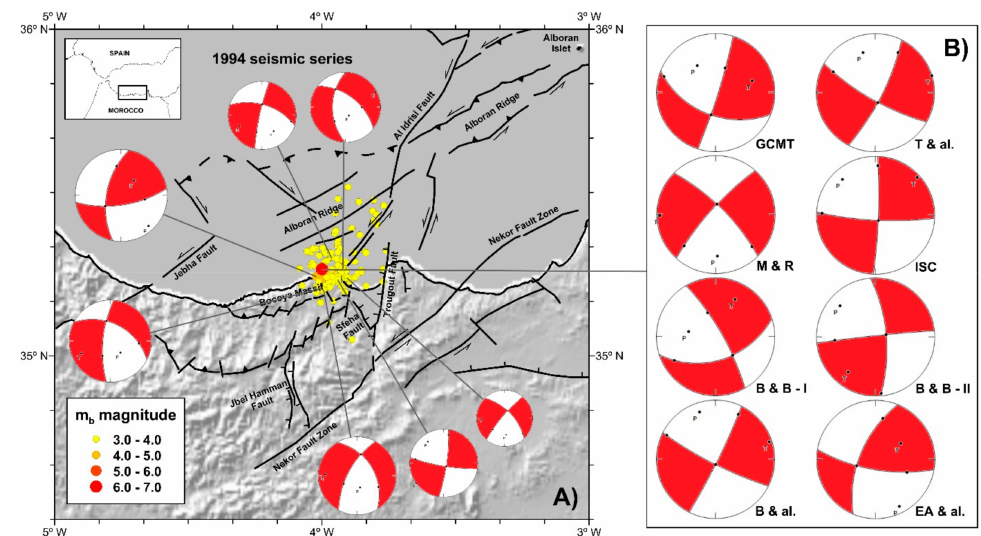
Figure 4. ( A ) 1994 seismic sequence showing earthquakes with magnitude above 3.0 and computed focal mechanisms for aftershocks [32]. ( B ) Different focal mechanism solutions for the mainquake. GCMT: Global Centroid Moment Tensor; T&al.: [40]; M&R: [38]; ISC: International Seismologi- cal Centre; B&B-I and B&B-II: [41], for a pre-event and the main quake, respectively; B&al.: [29]; EA&al.: [32,39].